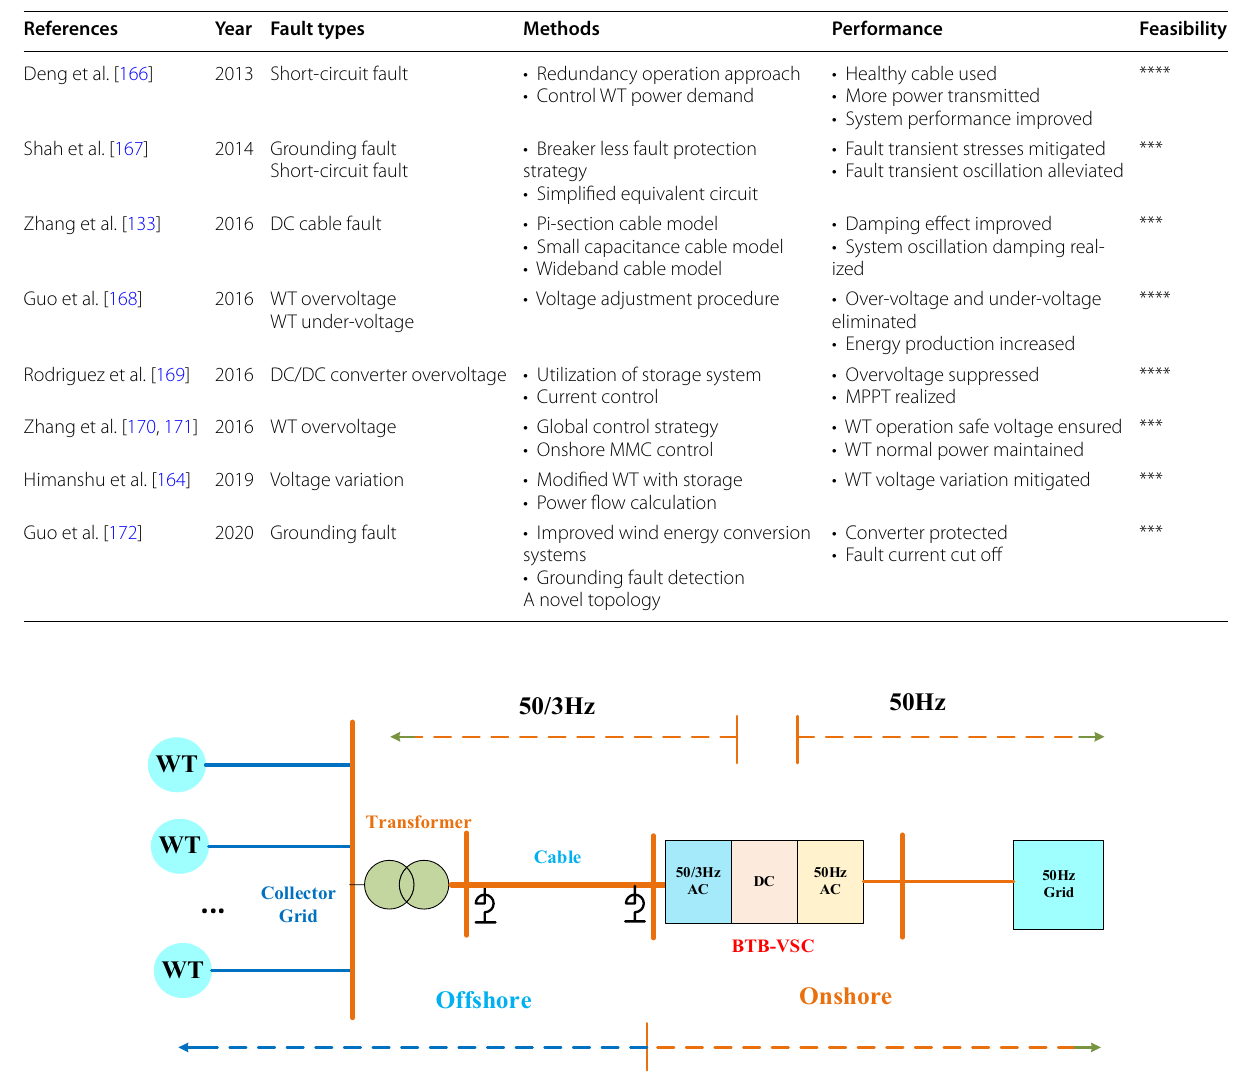
Fig. 16 General layout for LFAC